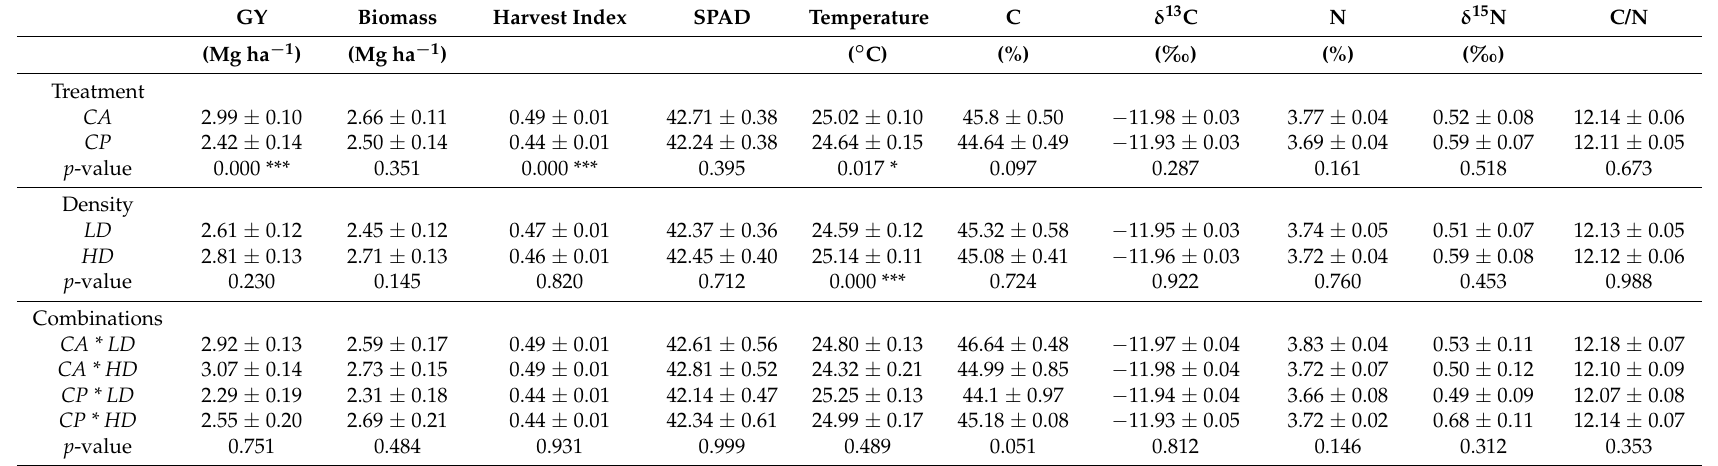
Table 2. Effect of the tillage conditions and planting density conditions on the yield parameters (GY, Biomass and Harvest Index), leaf chlorophyll content (LCC), leaf carbon and nitrogen concentration (C and N), leaf C/N ratio and the stable carbon ( δ 13 C), and nitrogen ( δ 15 N) isotopic composition. Values are means ± standard error. Level of significance ( p -value): *, p < 0.05; ***, p < 0.001. Treatments: CA, conservation agriculture; CP, conventional agriculture; LD, low density; HD, high density.